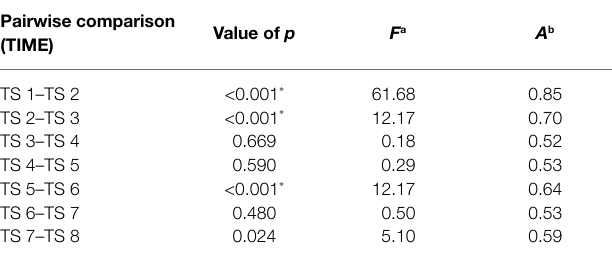
TABLE 1 | Pairwise post-hoc comparisons of the within-subject (sub-plot) factor TIME (training sessions = TS) on compound training scores (summarized time spent in the target zone for all nine protocols) during dynamic balance training. Pairwise comparison